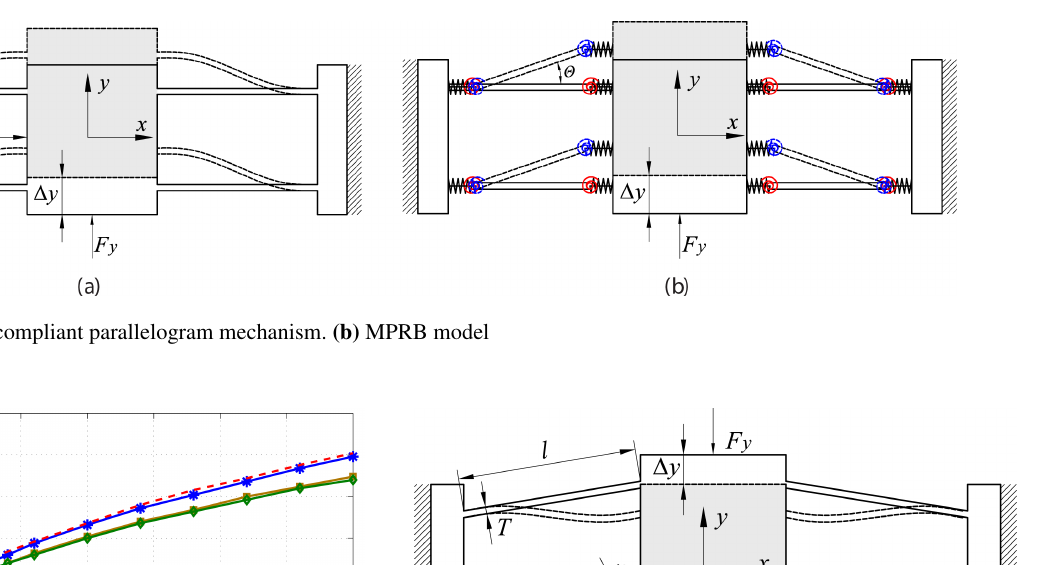
Figure 7. The deflection loci of the fixed-guided beam flexure. (a) P = 0. (b) P = 20N. (c) P = − 20N.